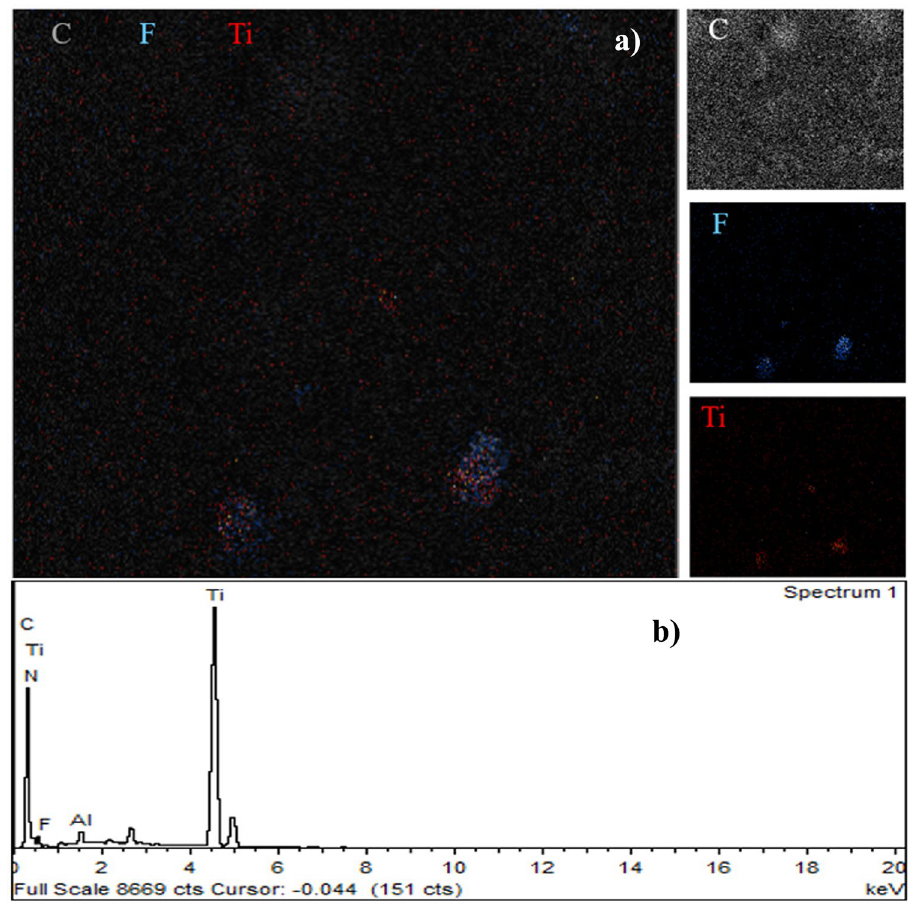
Figure 4. Elemental analysis of PAN/bio-based PU/Ti 3 C 2 T x MXene composite membrane: ( a ) element mapping images and ( b ) EDX spectrum indicating Ti in the nanofiber.